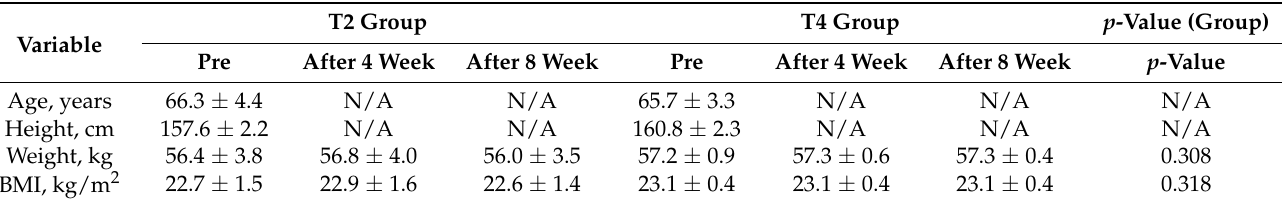
Table 1. Summarizes the characteristics of both groups.